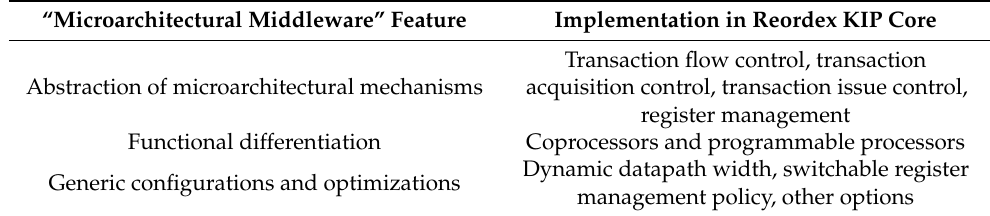
Table 3. “Microarchitectural middleware” design level features of Reordex KIP core.